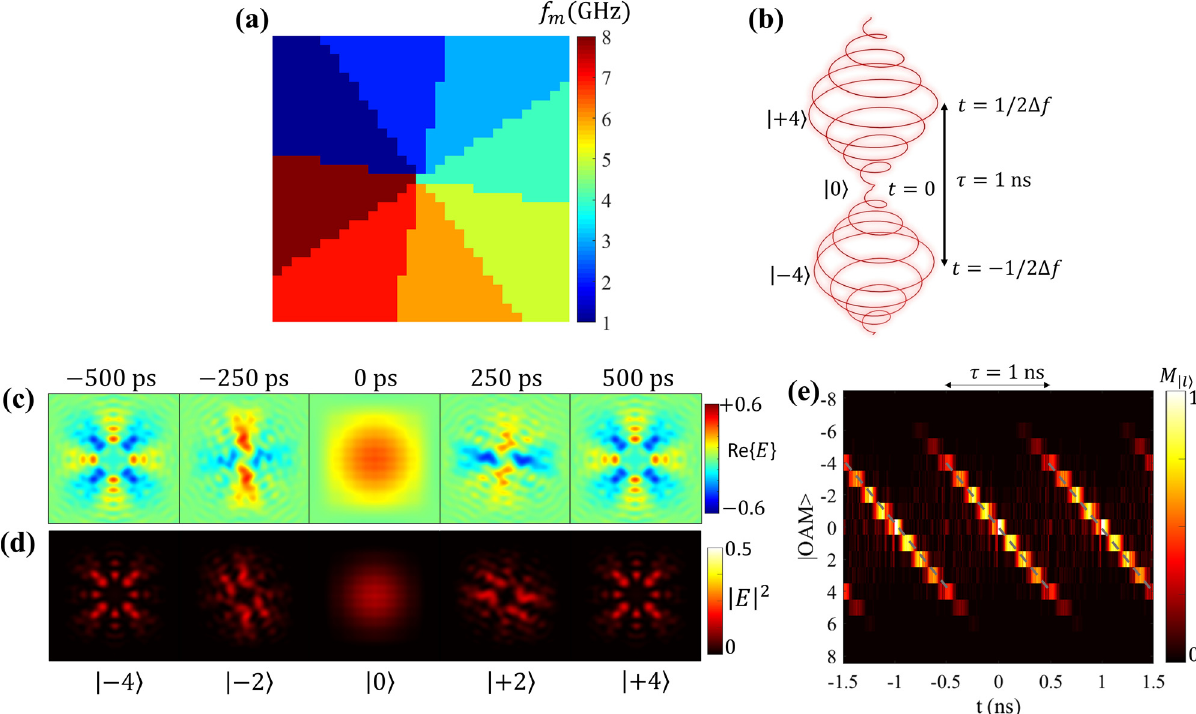
Figure 7: (a) The spatial distribution of modulation frequency across the metasurface aperture. (b) The schematic depiction of temporal evolutionofthedynamictwistedlightbeamgeneratedbythefrequencygradientTMMbiasedwiththesawtooth-likewaveform.Thecalculated (c) real part and (d) intensity of the re fl ected electric fi eld from the frequency gradient TMM biased with sawtooth-like waveform across the transverse x-y plane at a distance of 2 λ 0 above the metasurface at different instant of times within time-interval of T = 1 ns in the steady- state. (e) The normalizedspatialmode purity of there fl ectedlight fromazimuthallydivided frequency gradientTMMcalculatedas functionsof OAM state and